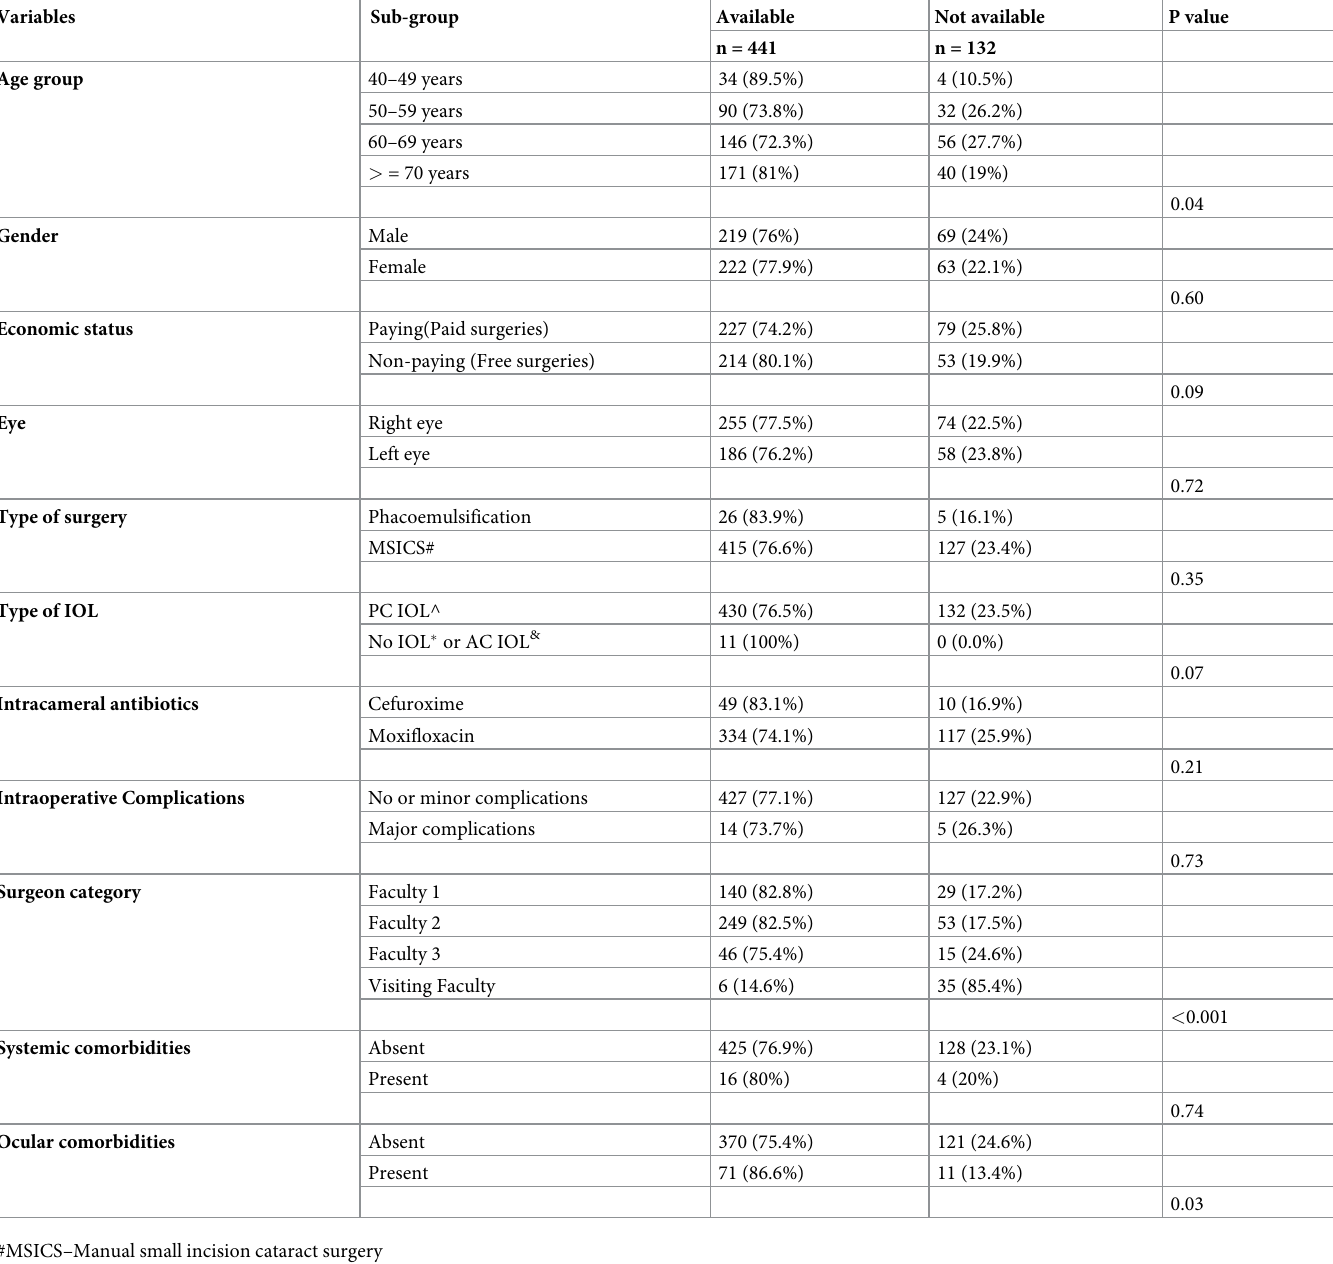
Table 3. Demographics and ocular findings of those who followed up and who did not follow up between 4–11 weeks of follow up.